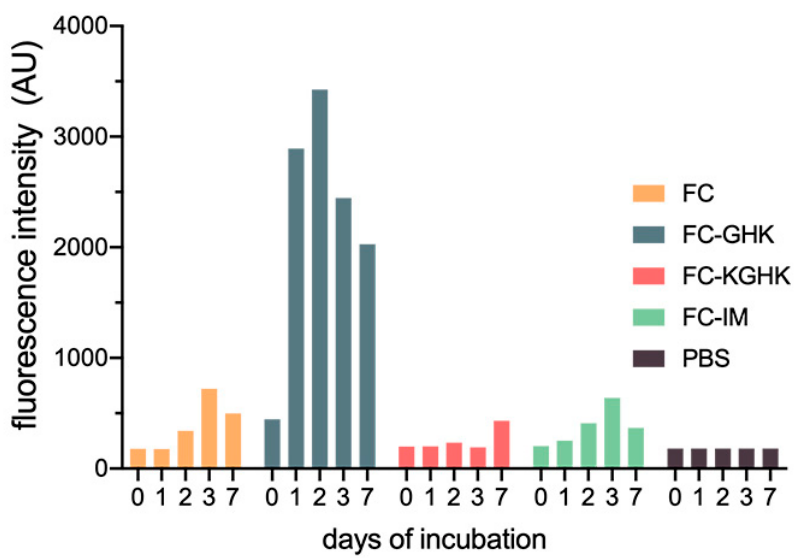
Figure 4. Dependence of the fluorescence intensity of the peptide-thioflavin T complex on the time of incubation, relative to a control (PBS solution).